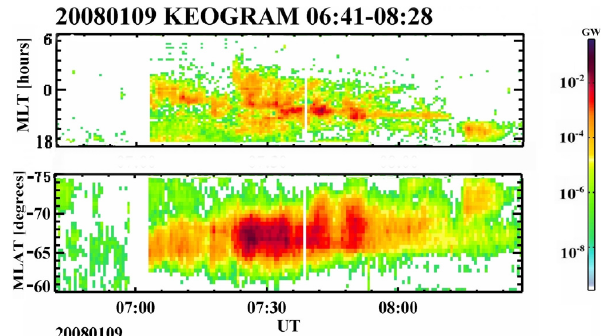
Fig. 1. POLAR UVI keograms during 06:41UT to 08:28UT on 9 January 2008: the first breakup occurred during the interval of the data gap from 06:59UT to 07:02UT around mid-night. The second breakup appeared at about 07:22UT at